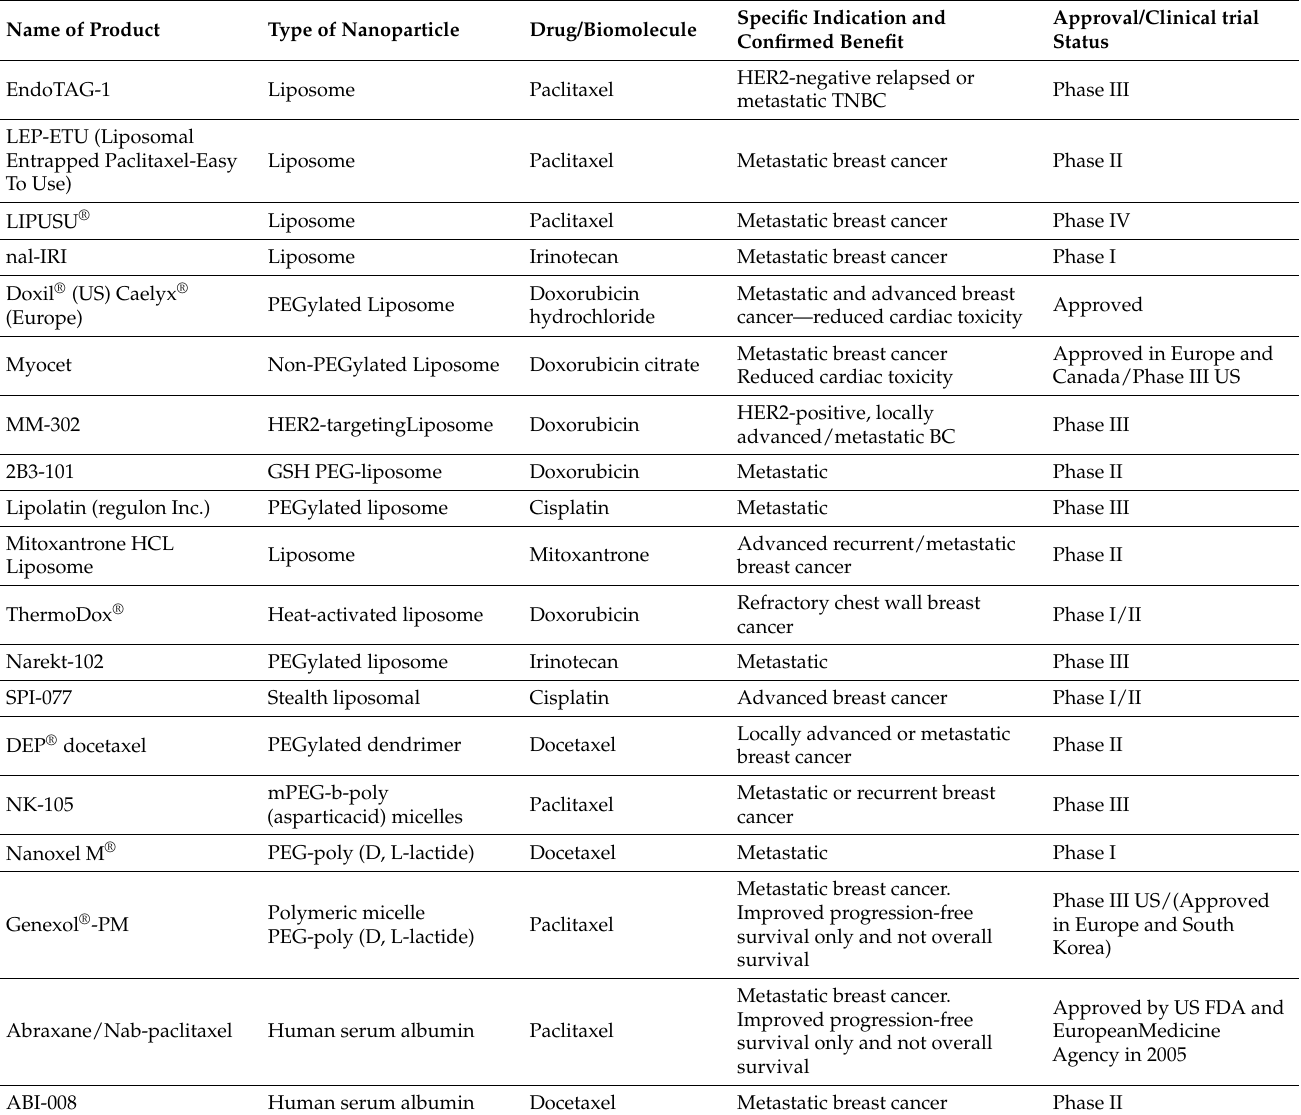
Table 5. Nanoparticles clinically approved or under clinical trial investigation for breast